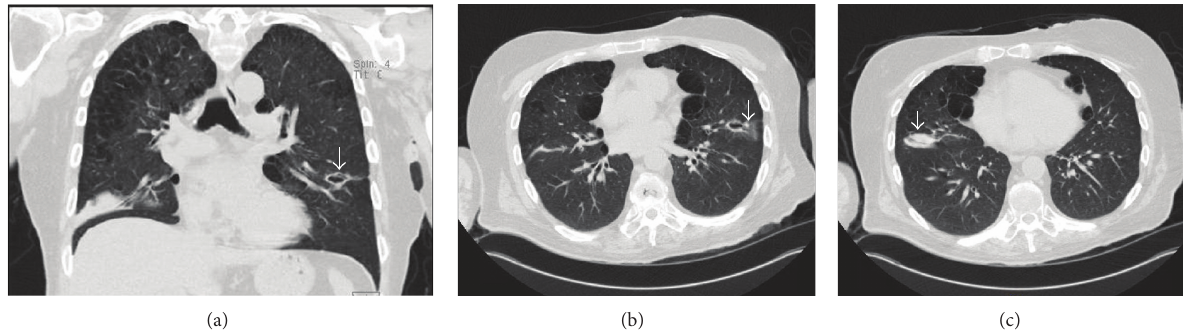
Figure 5: Chest CT scan. Coronal view (a) and axial views ((b) and (c)) showing a right lower lobe mass-like dense opacity with a left lower lobe cavitary lesion (arrows) and upper lobe predominant paraseptal